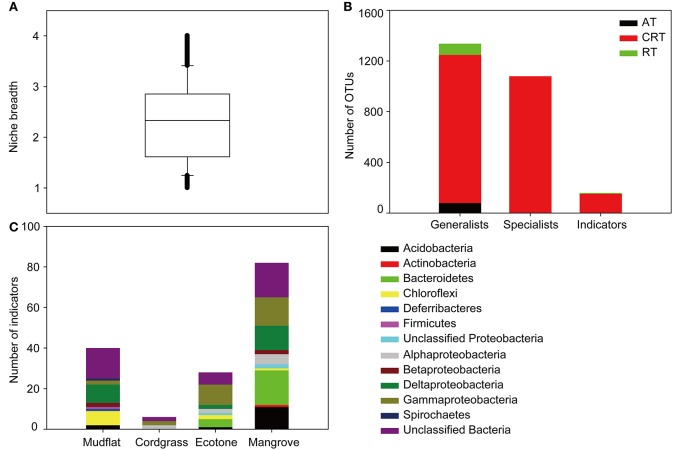
Habitat specialization of different OTUs based on niche breadth and INDVAL (INDicator VALues) analysis. (A) Distribution of niche breadth values of all selected OTUs. (B) The number of generalists, specialists, and strict habitat specialists (indicators) belonged to abundant, conditionally rare and rare taxa. OTUs with niche breadth value >3 were arbitrarily defined as generalists, whereas those with niche breadth <1.5 were selected as specialists. For the indicators, phylotypes with a P-value < 0.05 and both, a fidelity and specificity value ≥0.8, were considered as a good threshold for strict habitat specialists (Dufrene and Legendre, 1997). AT, abundant taxa; CRT, conditionally rare taxa; RT, rare taxa. Indicators, strict specialists. (C) The number and taxonomic composition of strong indicator taxa for the specific vegetation zones. Four habitats were mudflat, cordgrass, ecotone, and mangrove.